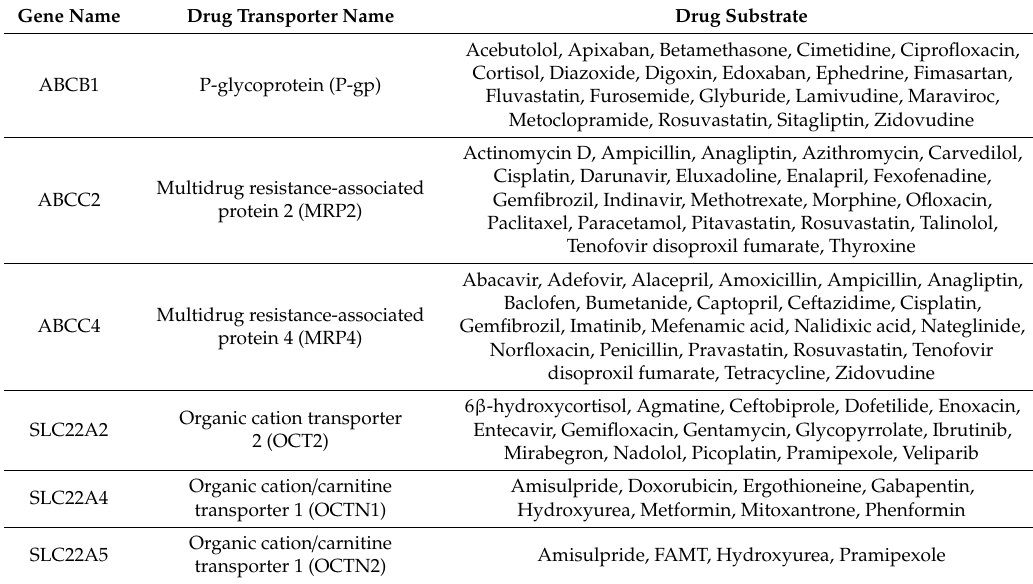
Table 1. Drug substrates of renal drug transporters (adapted from reference